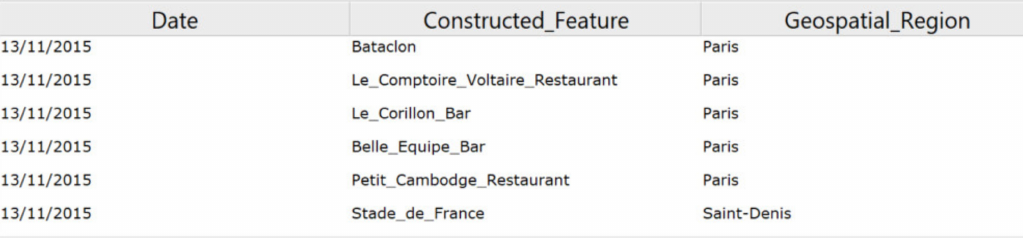
Figure 20. SPARQL query and results of spatial and temporal information of the terrorist attacks. Query 2: Who were the command members of each involved unit?